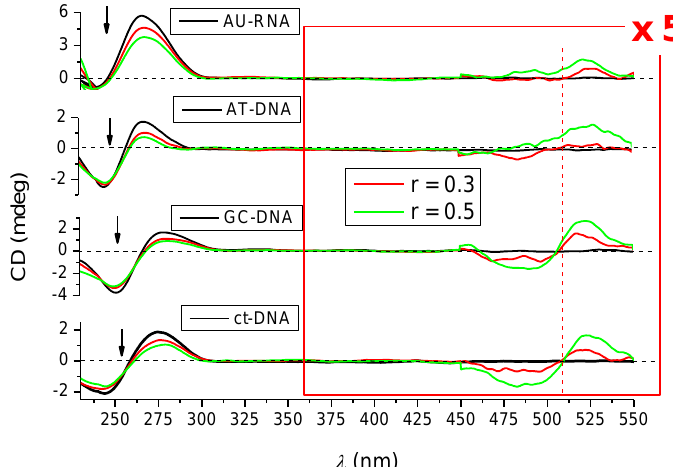
Figure 3. Circular dichroism (CD) titration of ds-DNAs and ds-RNA ( — ; c = 2 × 10 − 5 M) with 2 at molar ratios r [2] / [polynucleotide] = 0.3 ( — ) and 0.5 ( — ). Note that marked range 450–550 nm was multiplied by 5 for better visibility. Done at pH 7, sodium cacodylate buffer, I = 0.05 M.